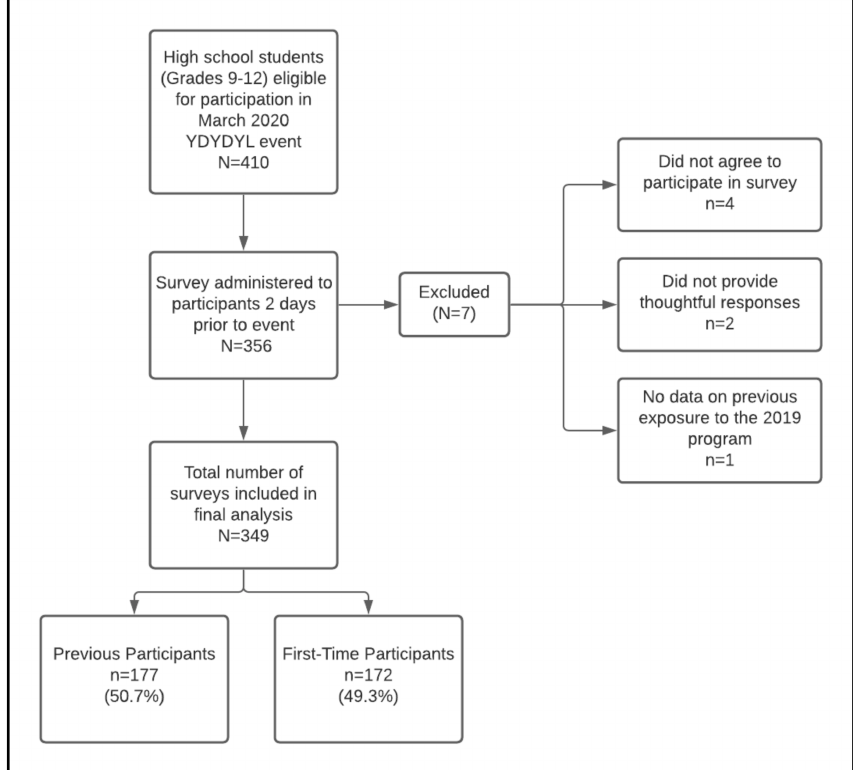
Figure 2. You Drink, You Drive, You Lose (YDYDYL) 2020 event survey